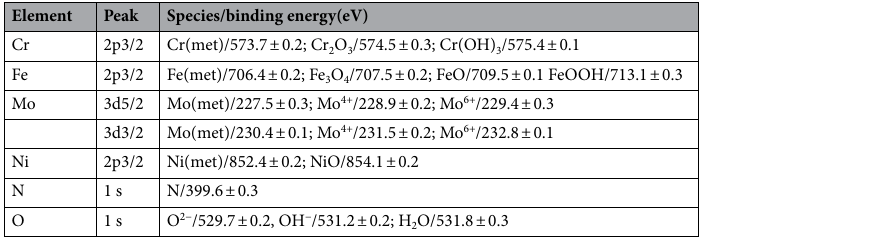
Table 6. Binding energy of main elements in the film layers.